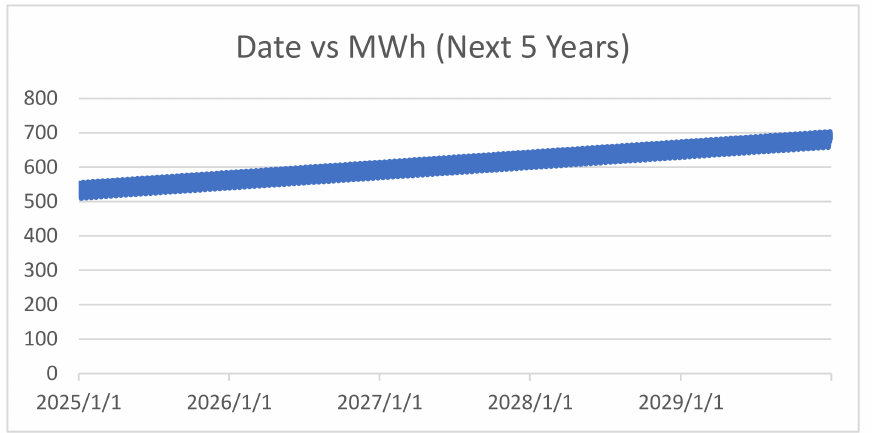
Figure 9. Second 5 years’ prediction results of MWh from 1 January 2025 to 1 January 2029. From 1 January 2020 to 1 January 2024 (the first 5 years), the power output